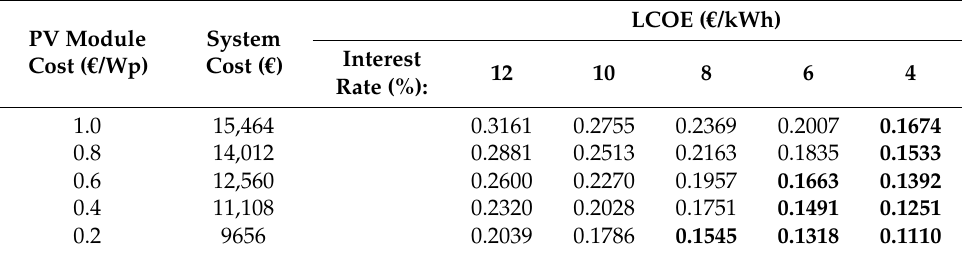
Table 5. LCOE over a range of interest rates (5000 W inverter, deterministic method).